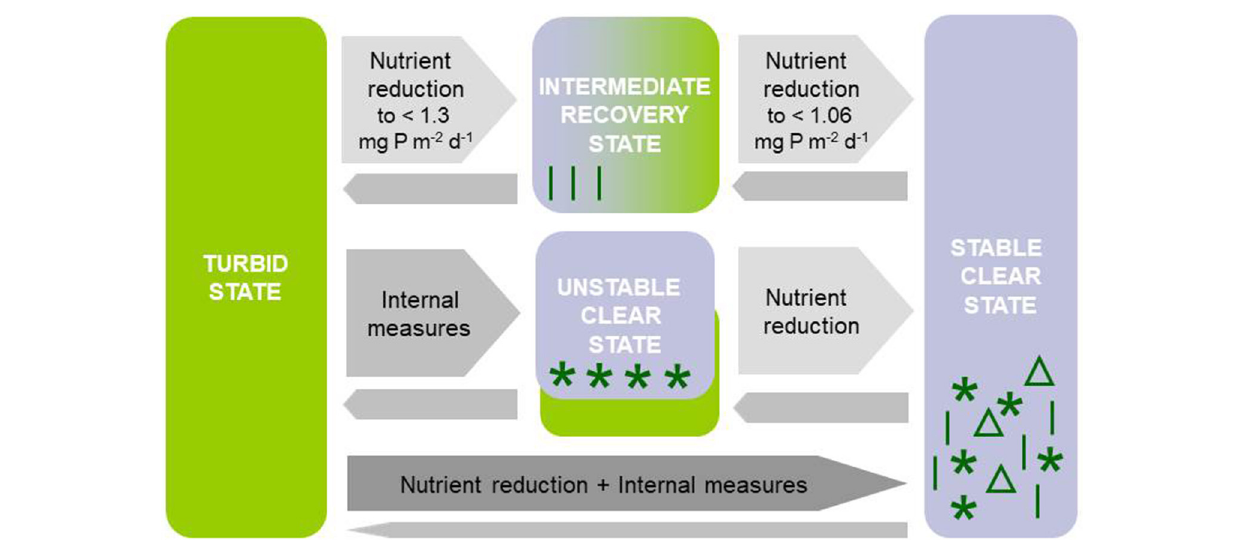
FIGURE 1 | Response patterns of turbid north temperate shallow lakes to different restoration measures: (1) External restoration measures (reduction of external nutrient loading) are expected to lead to an intermediate recovery state with clear-water conditions in spring and turbid water in summer and specific macrophyte communities with short growth seasons and eventually stable clear conditions with a diverse macrophyte flora if nutrient loading is reduced sufficiently or additional internal measures are applied (reversed order as suggested for eutrophication by Sayer et al., 2010a,b). Thresholds in phosphorus (P) loading are based on simulations using PCLake (see Figure 5 ). (2) Lake-internal measures (biomanipulation, sediment suction dredging) leading to unstable clear-water conditions with specific macrophyte communities that may collapse resulting in a shift back to turbid conditions unless nutrient loading is reduced, or (3) a combination of external and internal restoration leading to stable clear-water conditions with an abundant and diverse macrophyte